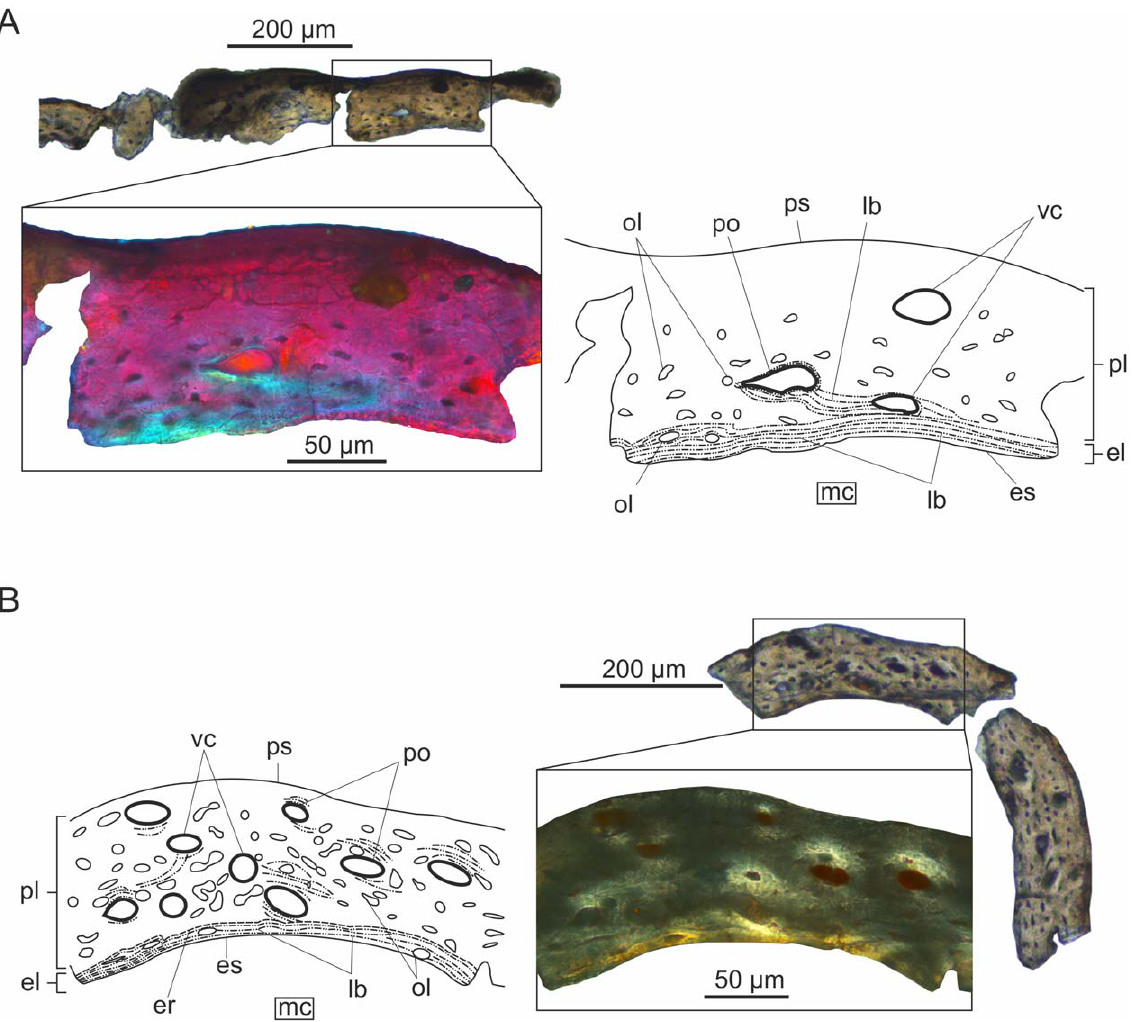
Figure 1. Transverse histological sections under crossed polarizers, and corresponding interpretative drawings of early juvenile long bones of Rhamphorhynchusmuensteri . (A) The cortex of the tibia in the smallest studied specimen BSPG 1960 I 470a is dominated by immature fibrolamellar bone. It is noteworthy that already in this early ontogenetic stage endosteal bone rims the medullar cavity. (B) The femoral cortex of BSPG 1877 X I reveals more mature fibrolamellar bone with numerous longitudinal vascular canals resulting in high degree of porosity. Both specimens exhibit large, plump osteocyte lacunae.